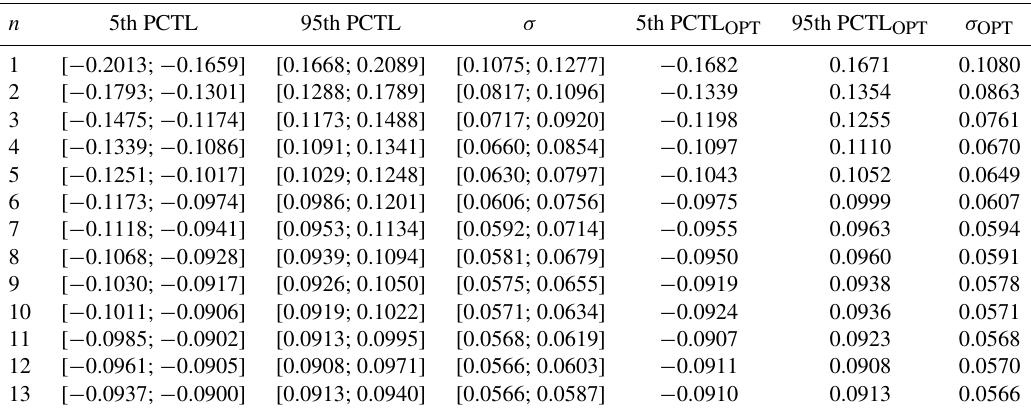
Table 3. Range of the 5th (second column) and 95th (third column) percentiles (PCTL) and the standard deviation (fourth column) of the hourly step-change function of the lumped power output time series for all possible combinations of n wind farms (first column) per installed wind power capacity; the wind farm capacities are equally distributed over all considered sites. The 5th (fifth column) and 95th (sixth column) percentiles and the standard deviation (seventh column) of the hourly step-change function for the combinations with the smallest spectral integral with respect to frequencies from (3h) − 1 to (2h) − 1